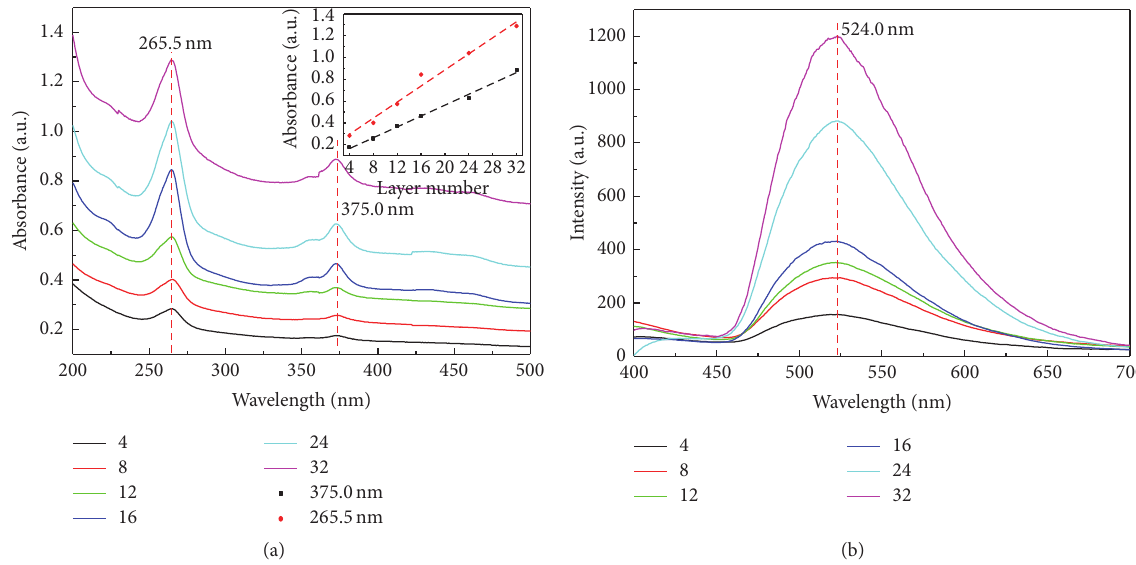
Figure 3: UV-visible absorption spectra and photoluminescence spectra of Co( 𝑛 )-films. The inset of (a) shows the absorbance increasing linear relationship in 263.5 nm, 338.0 nm, and 375.0 nm.